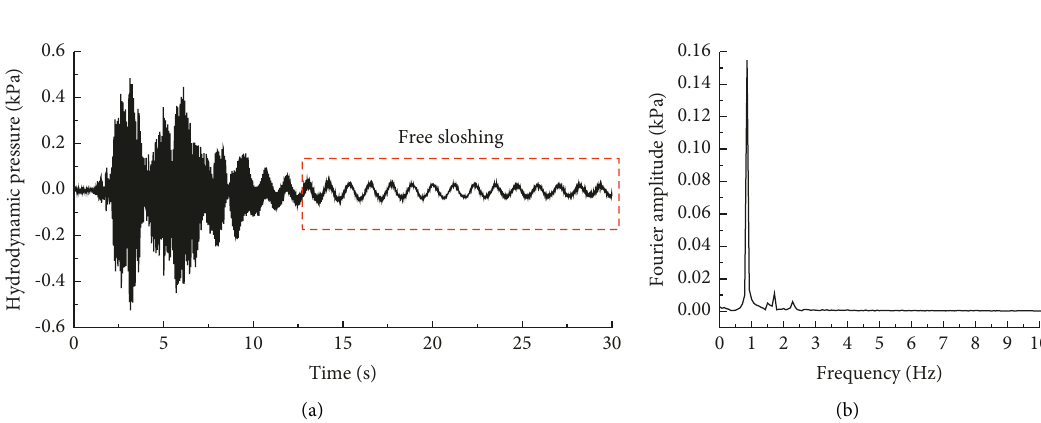
Figure 13: Data processing of hydrodynamic pressure record. (a) Time history of hydrodynamic pressure. (b) Fourier